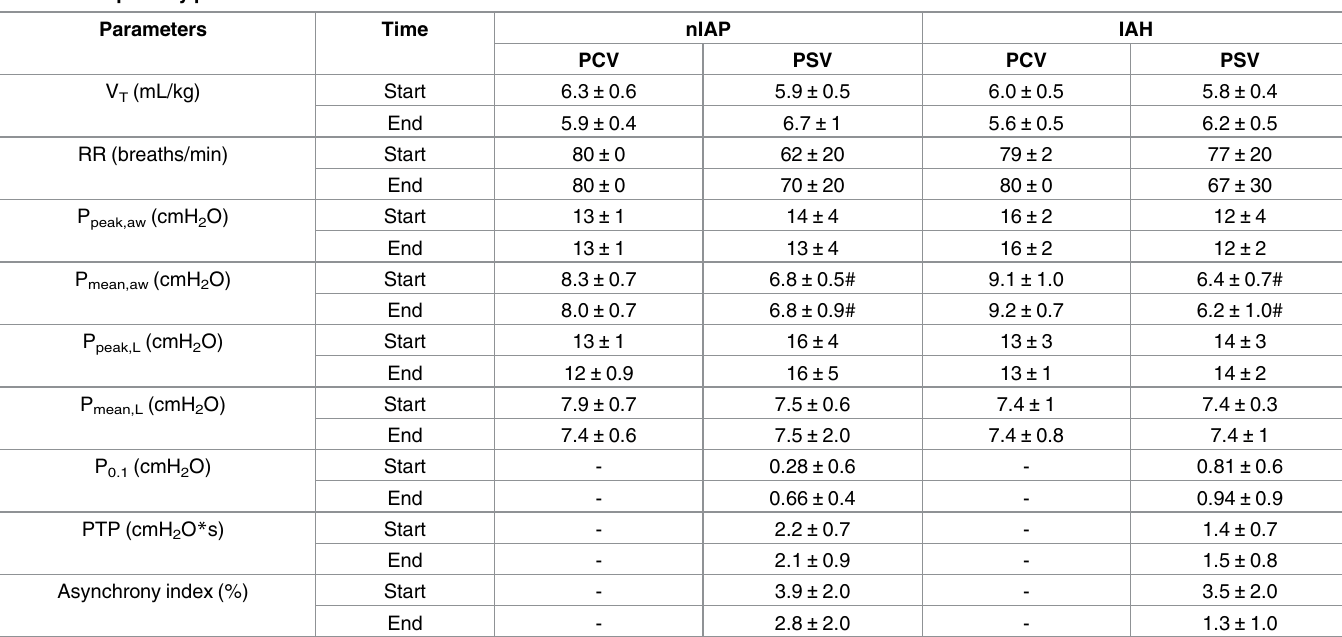
Table 2. Respiratory parameters at Start and